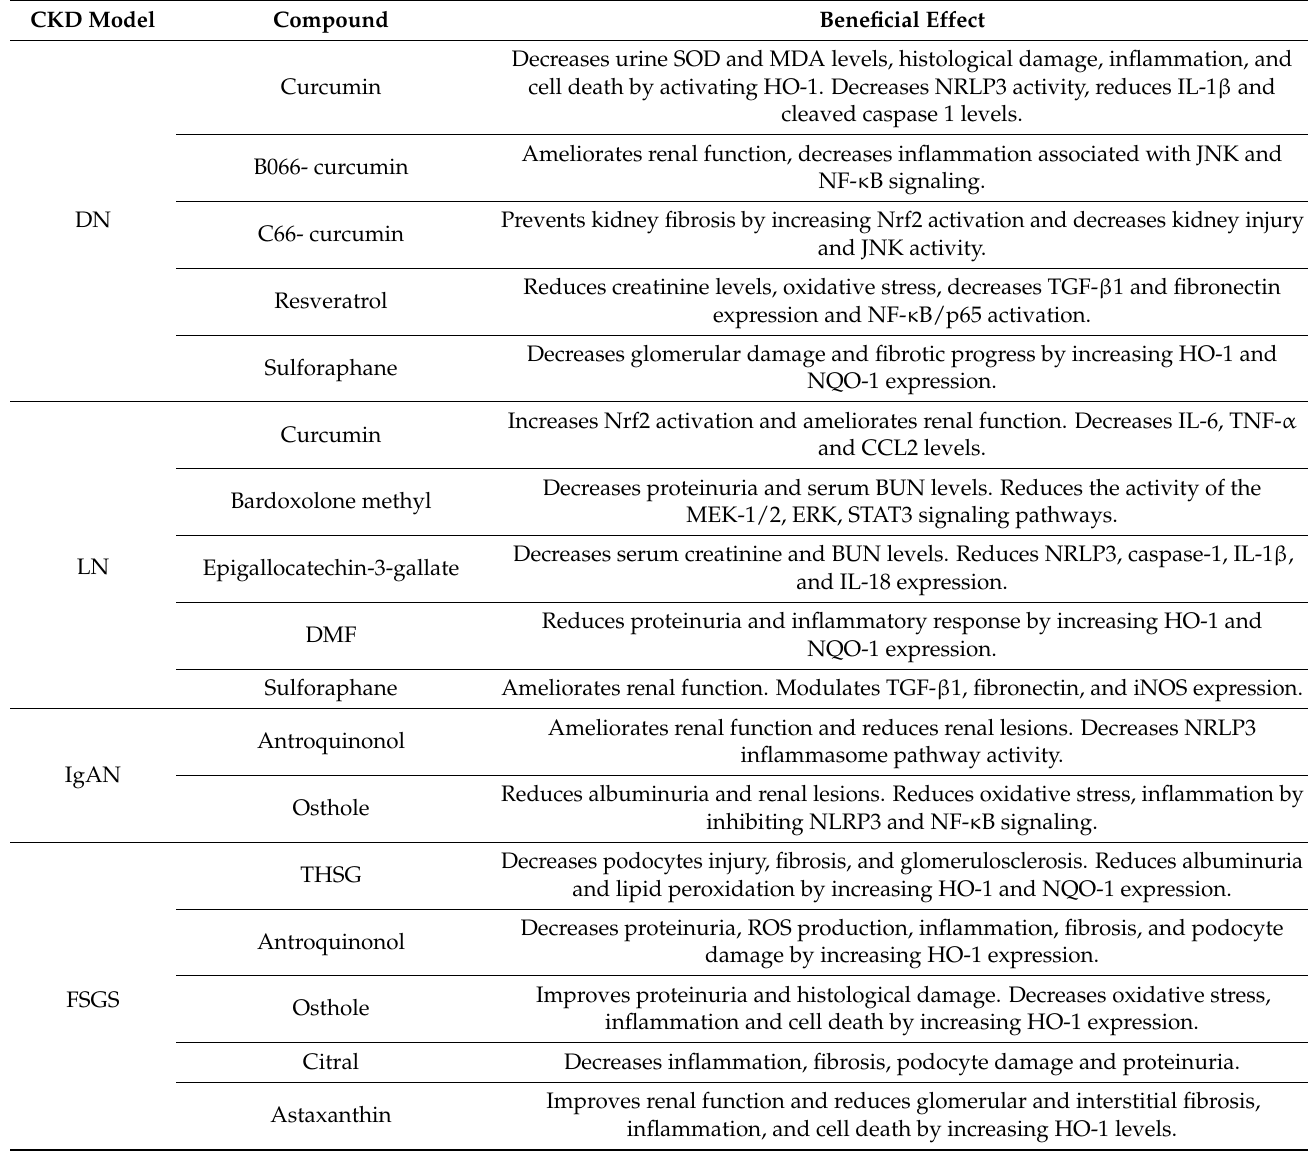
Table 3. Beneficial effects of Nrf2 inducers in